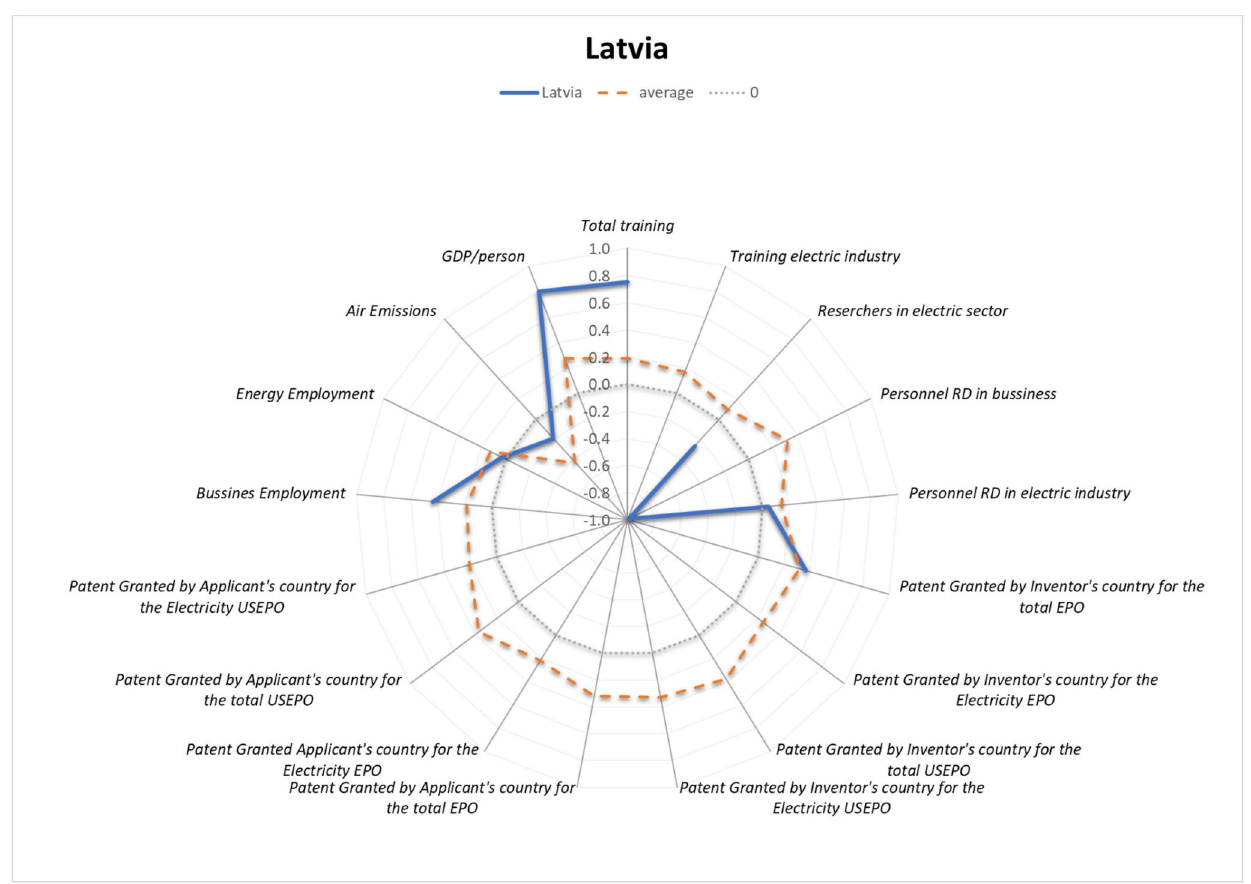
Figure 24. Synergy and trade-off occurrence—LV. Source: Authors’